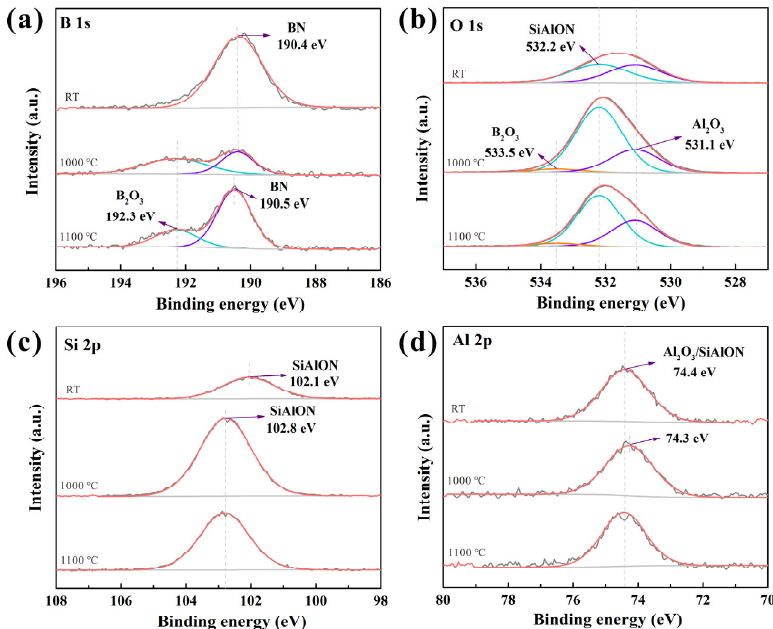
Fig. 9 XPS spectra of the surface of PcBN/hBN fibrous monolithic ceramics after mechanical tests at different temperatures. spectra of B 1s and O 1s show that B